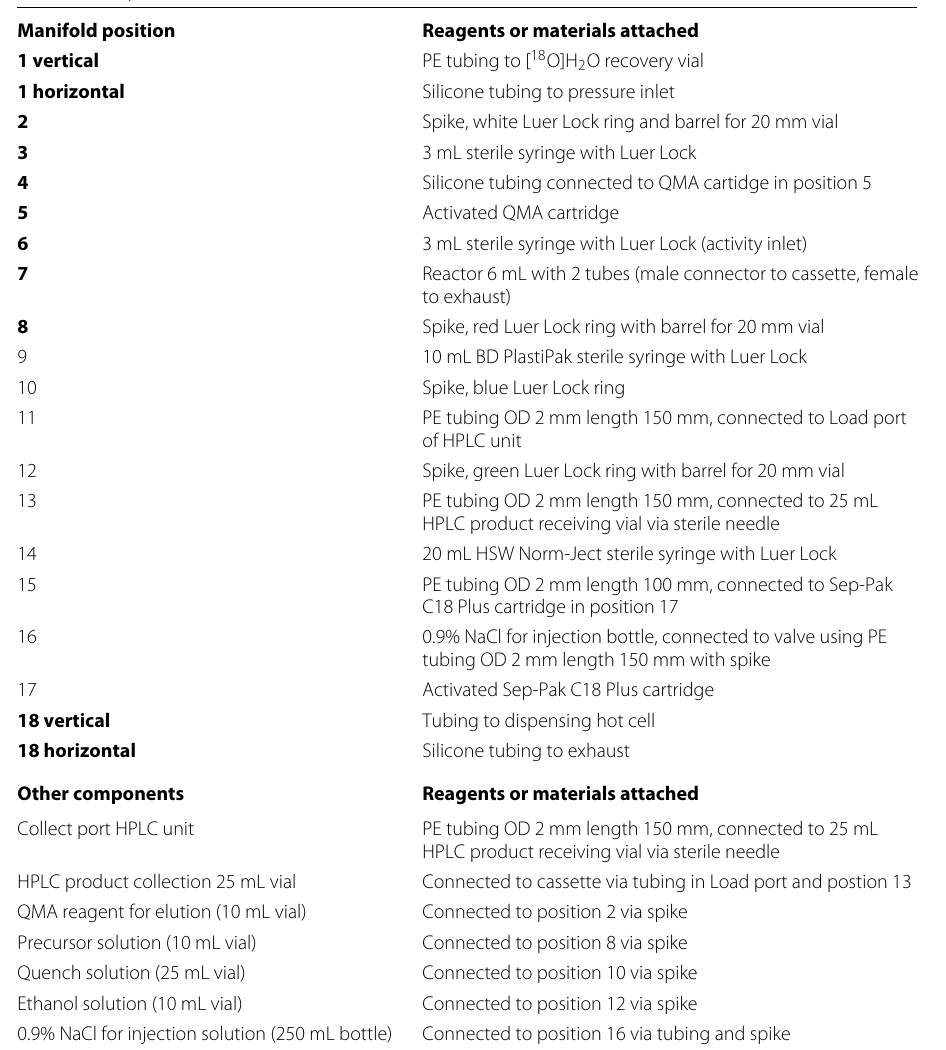
Table 2 Outline of the [ 18 F]DPA-714 cassette on the Trasis AllinOne radiosynthesiser, with description of reagent and materials position. Positions outlined in boldface are original parts of the commercially available [ 18 F]FDOPA